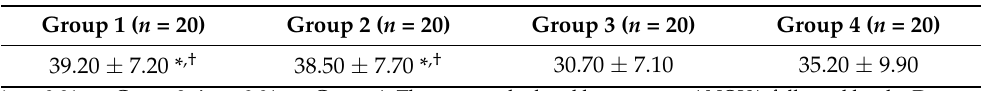
Table 1. Age (years) of the patients.